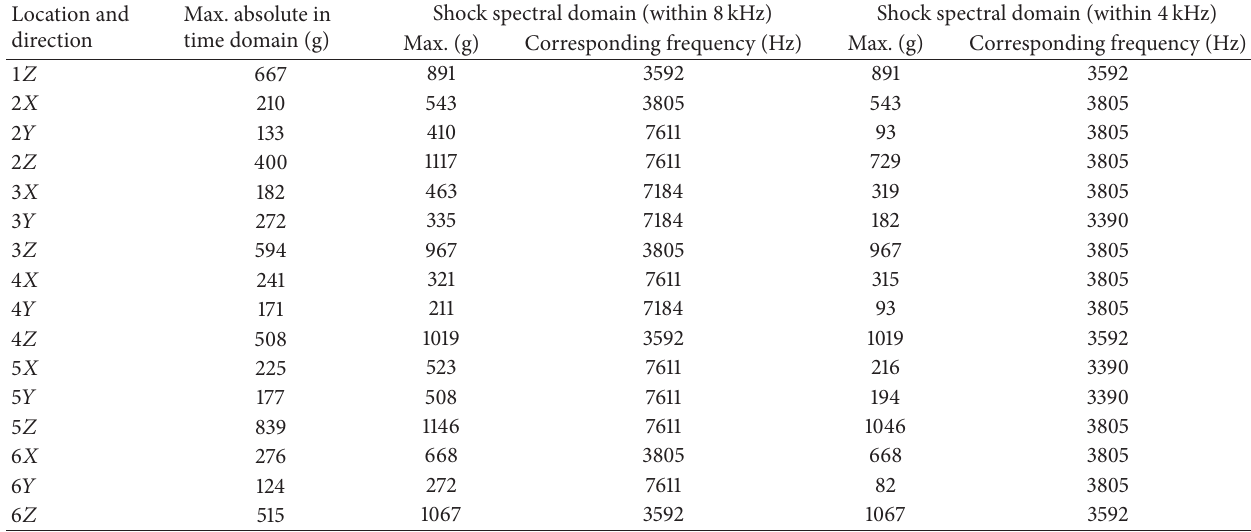
Table 3: Experimental results of combined honeycombs 8mm A + 4.5 mm B.